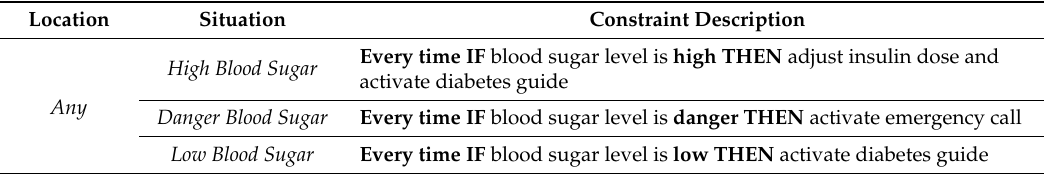
Table 3. Constraints specified by the doctor.